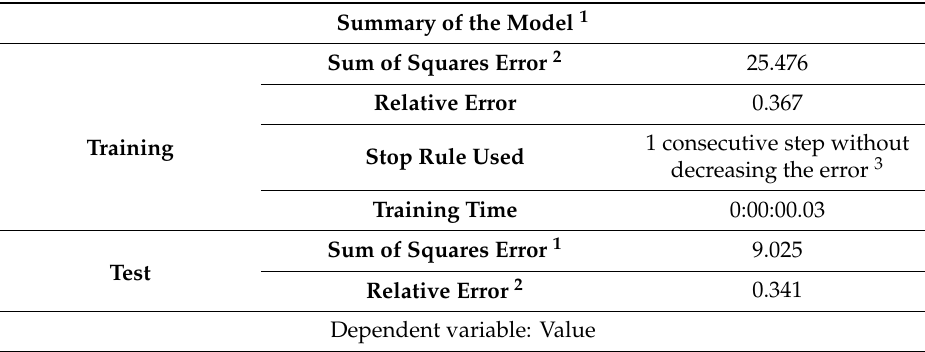
Table 6. Adjustment of the neural network Value.